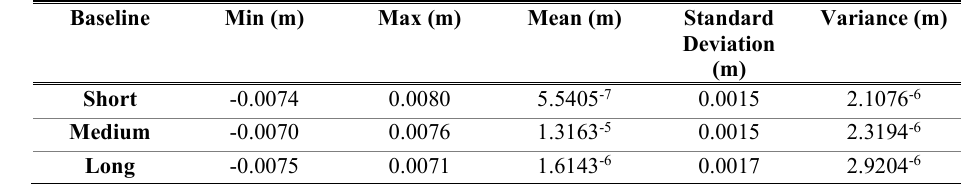
Table 3. Statistical analysis on non-dispersive medium of GPS distance-dependent